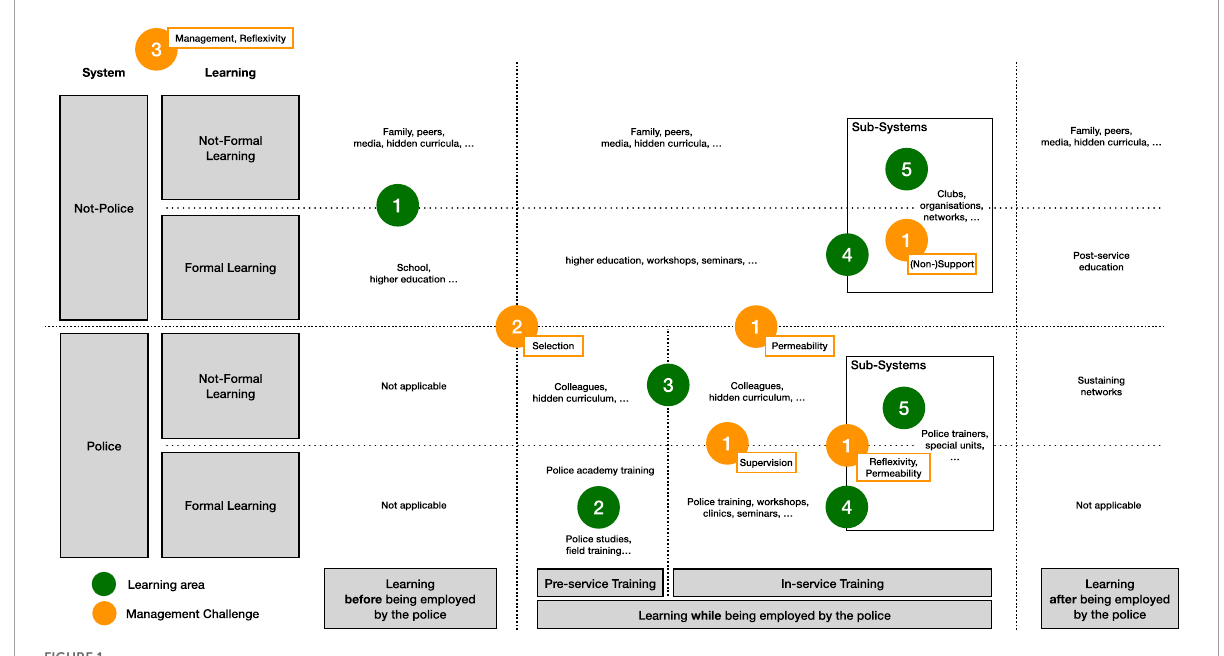
FIGURE1 Police learning management